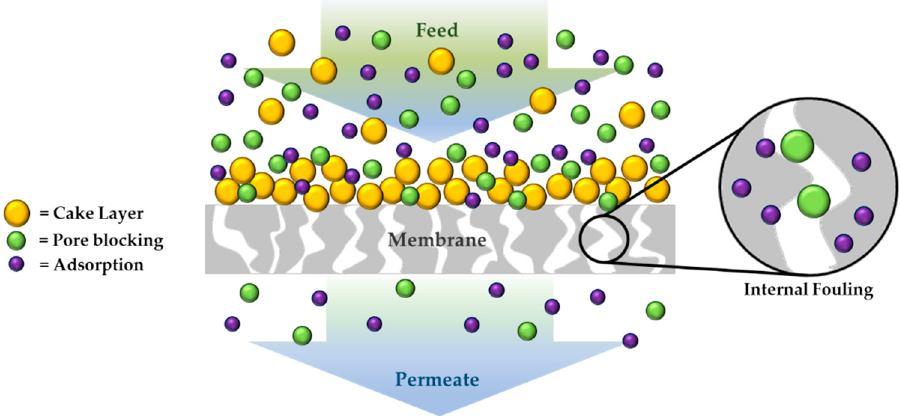
Figure 3. Different mechanisms of membrane fouling.